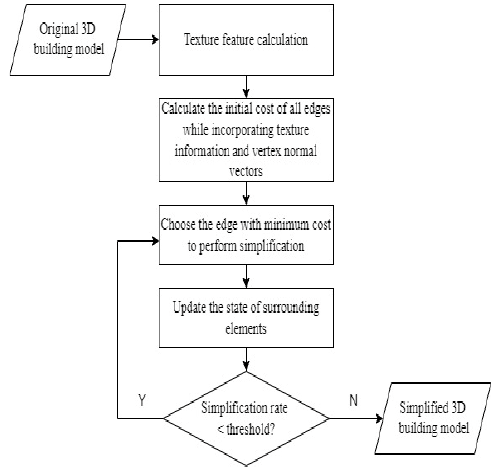
Figure 1 . Flowchart of the